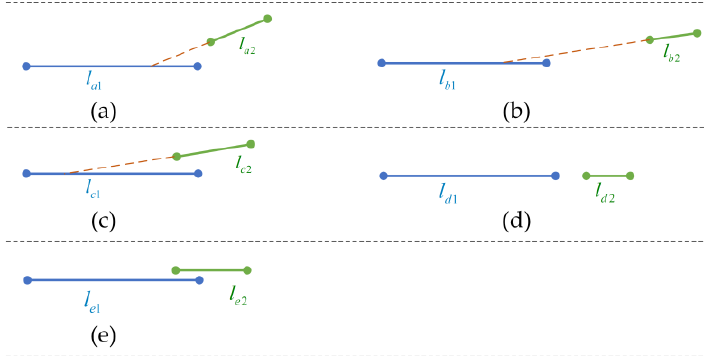
Figure 8. Typical adjacent line segment relationship. ( a ) The angle difference is too large. ( b ) The endpoint distance between line segments exceeds the threshold value. ( c ) The line segments overlap. ( d ) The ideal situation of collinear disjoint. ( e ) The parallel disjoint but overlapping situation.